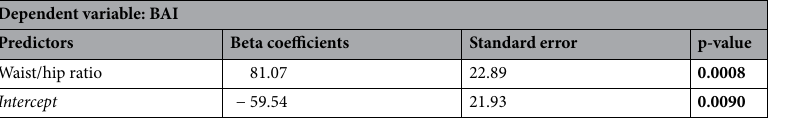
Table 6. Linear regression model for predictors of BAI among 53 postmenopausal women. R = 0.44, R 2 = 0.20, adjusted R 2 = 0.18, F (1,51) = 12.54, p < 0.01. The model was adjusted for skeletal muscle mass (p = 0.678), basal metabolic rate (p = 0.577), and insulin (p = 0.354). Bold values indicate statistical significance of p < 0.05.